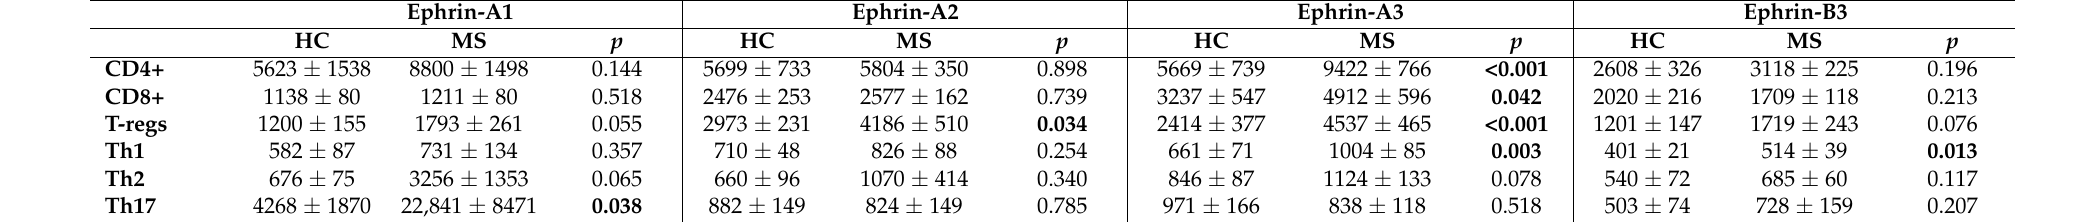
Table 3. Ephrin mean fluorescence intensity on different T cell